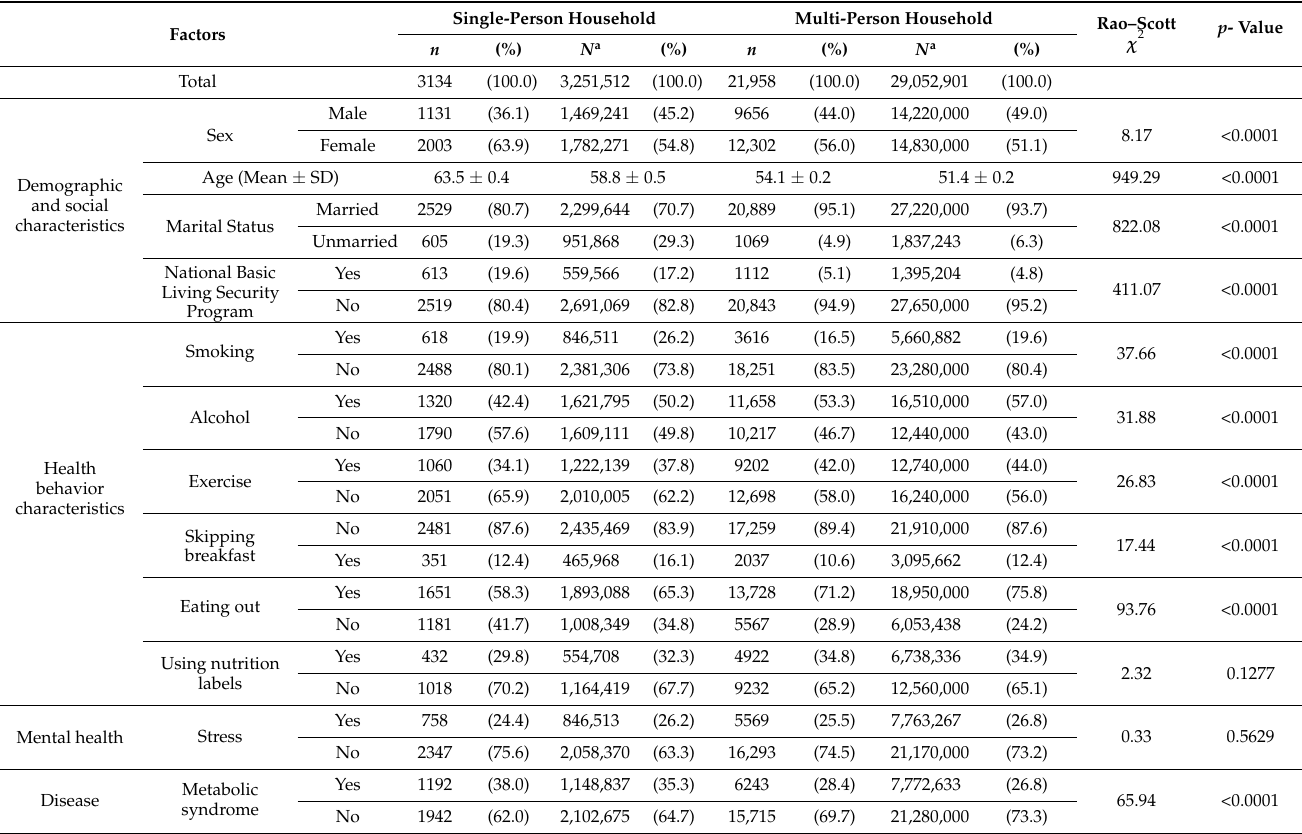
Table 2. General characteristics among the single- and multi-person